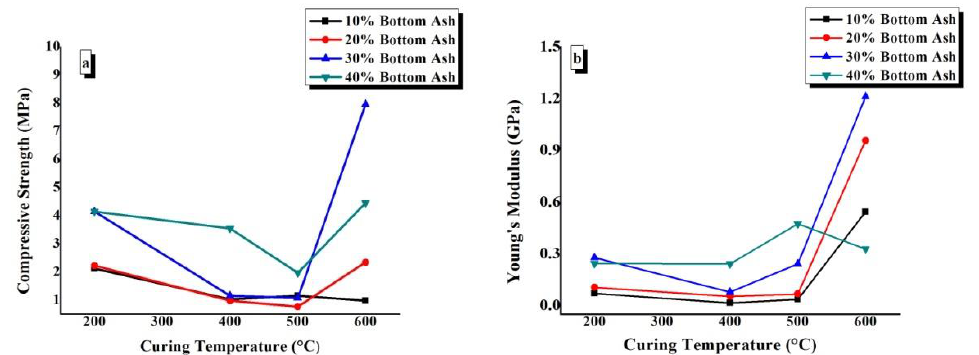
Figure 12. Effect of curing temperature on the ( a ) compressive strength and ( b ) Young’s modulus of TGPFs of the same composition.